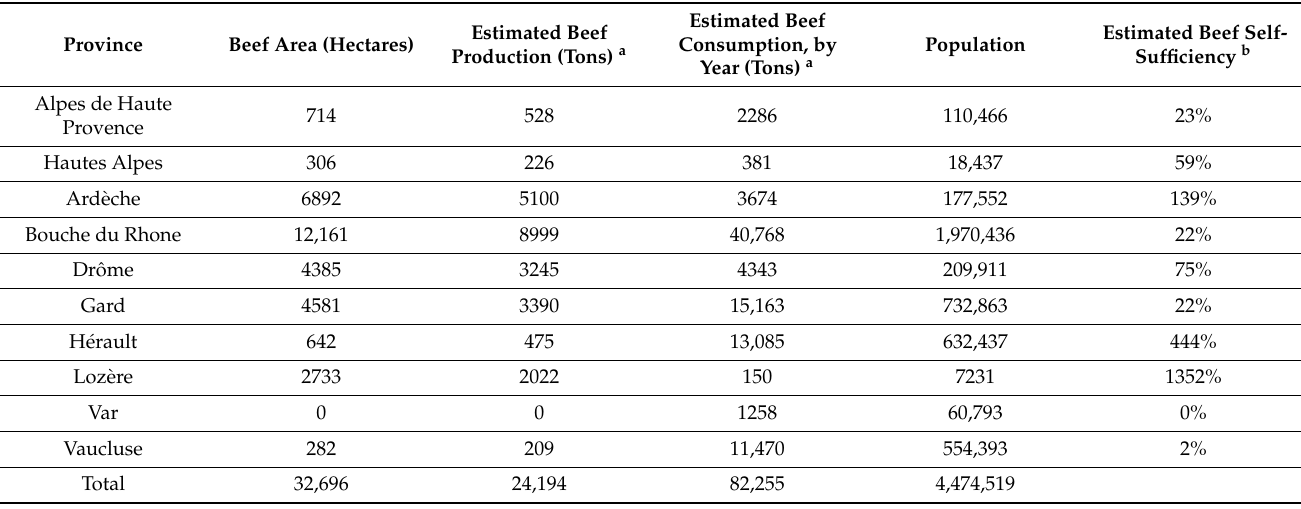
Table 5. Estimation of beef self-sufficiency ratio.